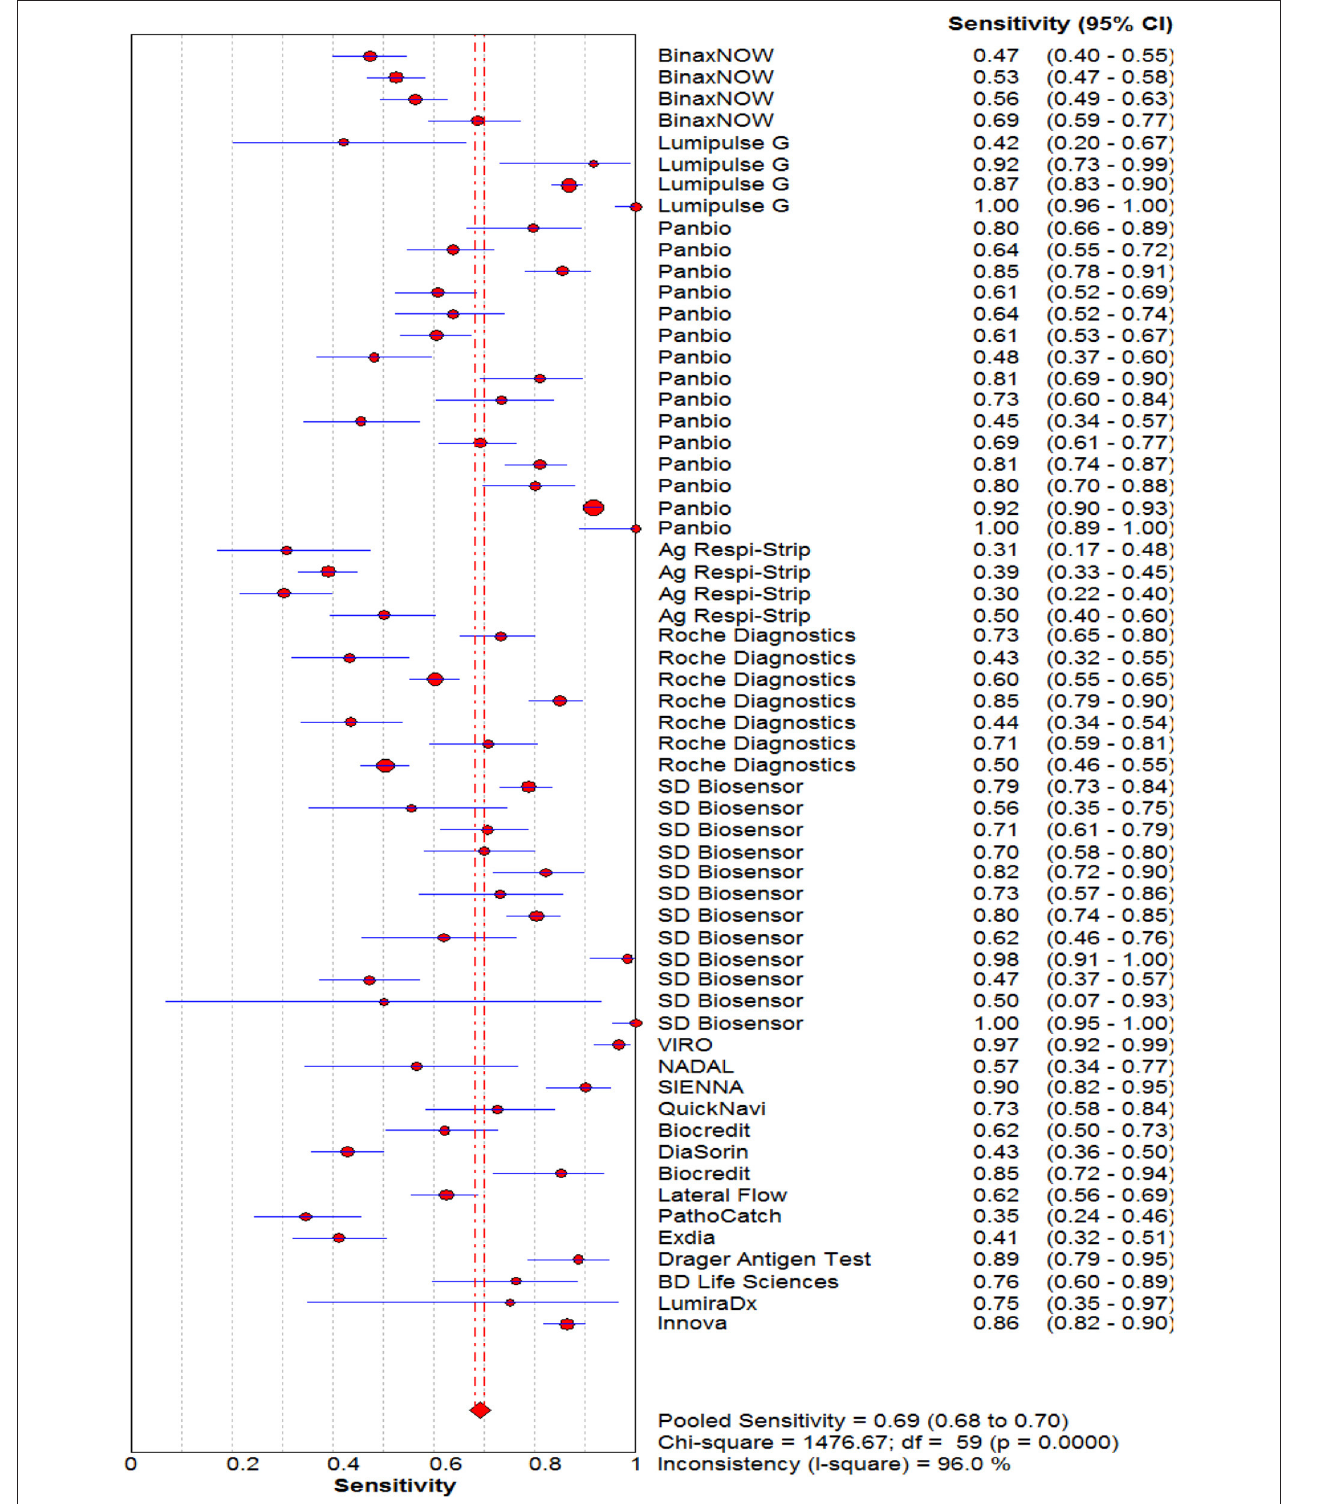
FIGURE 2 | Forest plot of pooled sensitivity of rapid antigen tests for the diagnosis of COVID-19. The point estimates of sensitivity from each study are indicated as a circle and a 95% confidence interval is shown with a horizontal line.